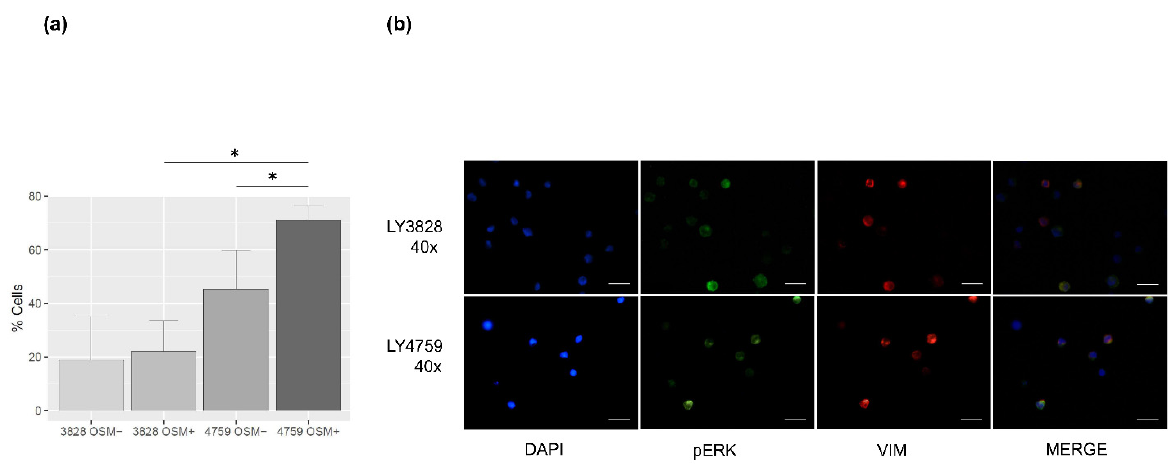
Figure 2. Perinuclear inclusions in H187 (LY3828) and p.H187Q homozygous variant (LY4759). ( a ) The amount of perinuclear formations are represented as means and standard deviations of the percentage of cells with inclusions obtained by three independent experimental session replicates. The inclusions percentage is higher in the p.H187Q homozygous HAEC LY4759 cell line than in the LY3828 cell line. The amount of inclusions is significantly increased by OSM treatment in LY4759 cells only. Statistical differences are indicated by an asterisk (* p < 0.0001); ( b ) immunofluorescence images of the OSM treated LY3828 and LY4759. Almost all the LY4759 cells showed round formations with the same localization as anti-Vim. The merge between pERK and vimentin is also displayed. The scale bar is 20 µm.